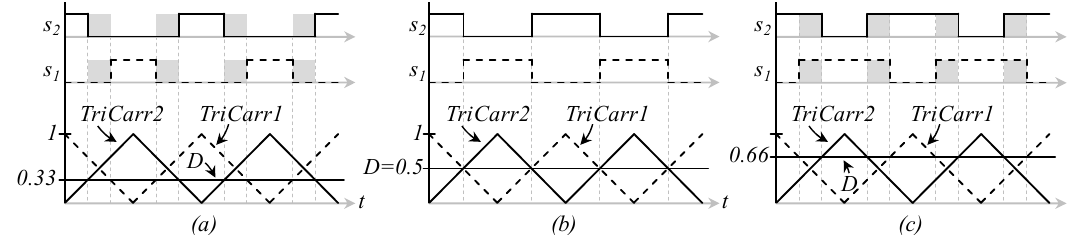
Figure 5. PWM scheme under several values of D , ( a ) D = 0.33, ( b ) D = 0.5, and ( c ) D = 0.66.